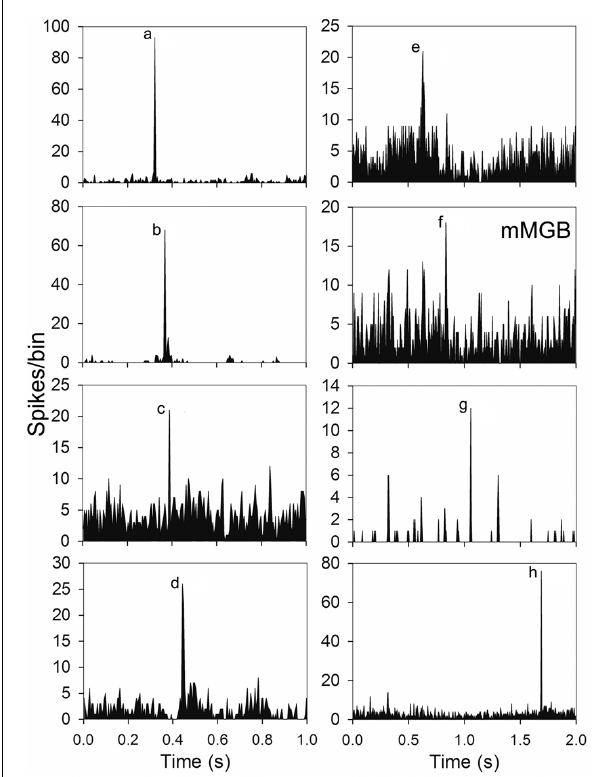
FIGURE 5 | Examples of PSTHs from seven units in AI(LF) and one from the medial MGB (mMGB) each of which showed a response to a different single element.